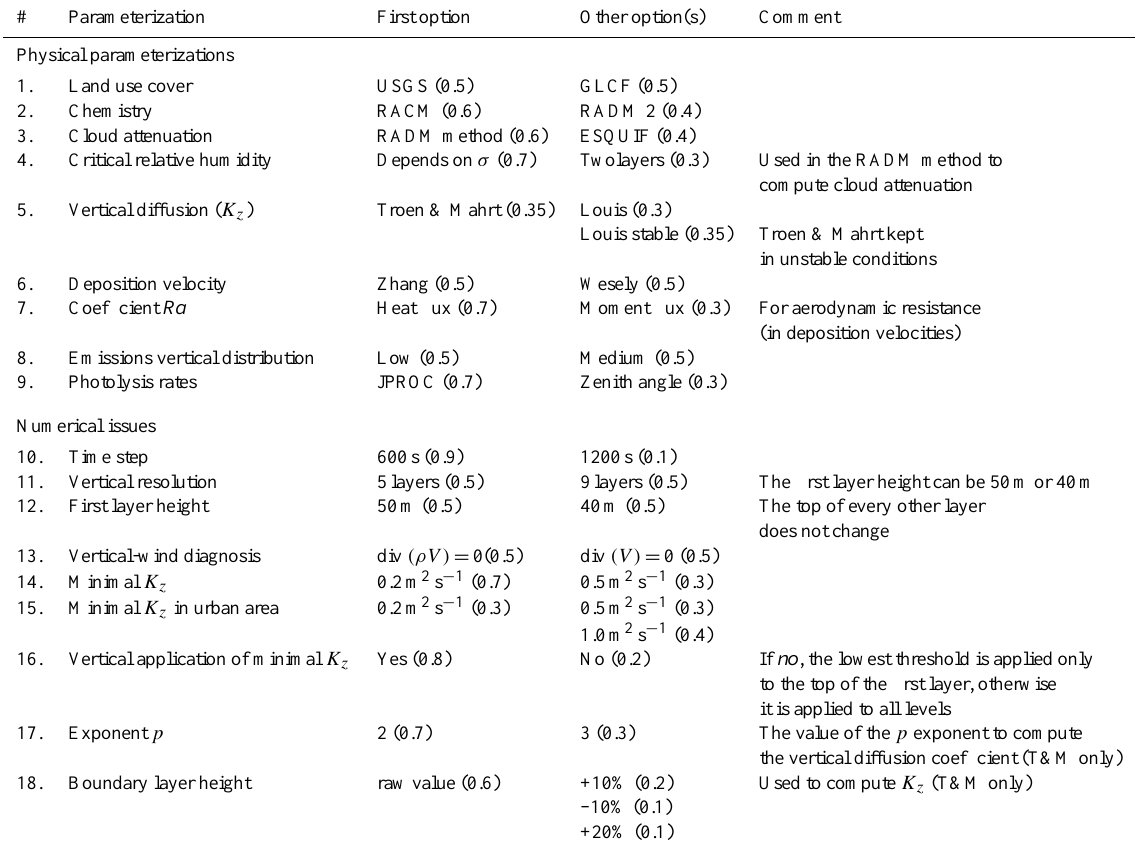
Table 1. Alternatives for the physical parameterizations and numerical options. The numbers enclosed in brackets correspond to the occurrence probability of an